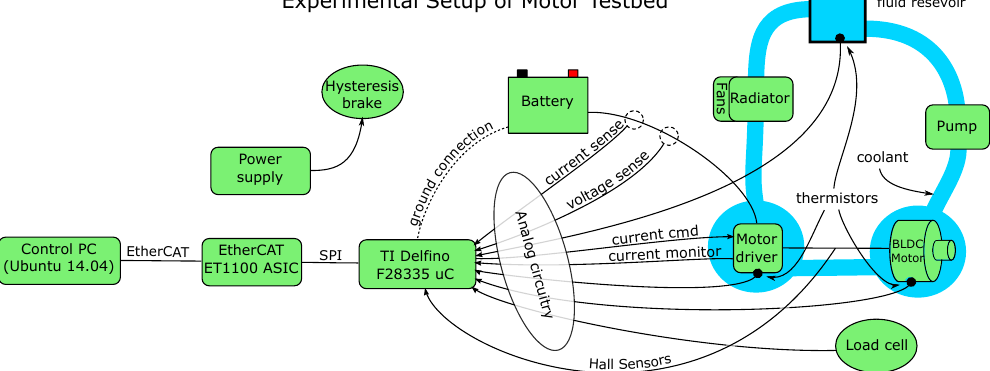
Figure 6. A block diagram showing the hardware interface used for experimental testing. Data are gathered on a Texas Instruments TMS320F28335 microcontroller and then passed to a control PC via